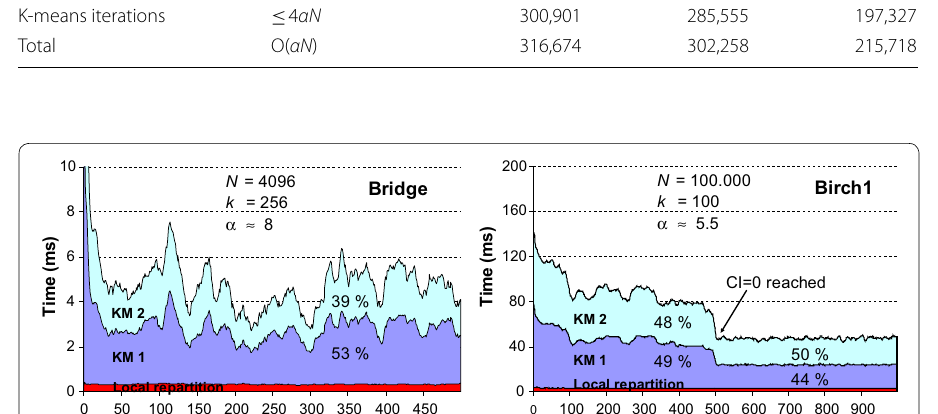
Fig. 5 Processing time profile with the random swap iterations. Time taken by the local repartition (steps 1–4) remains rather stable during the iterations whereas the time taken by k-means varies